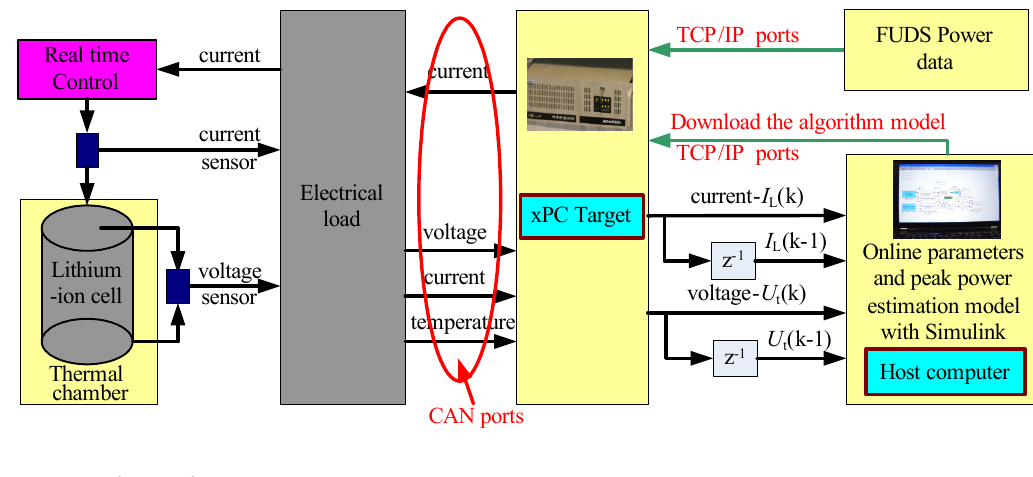
Figure 2. The test bench for HIL experiment.